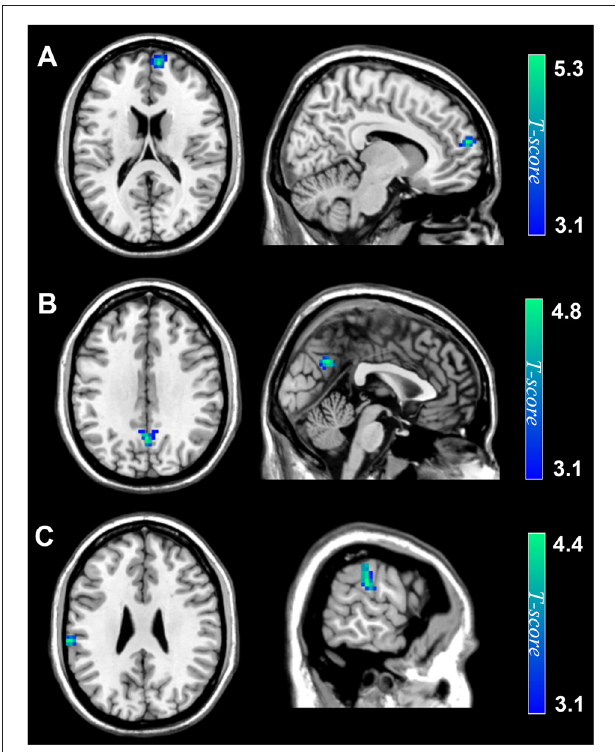
FIGURE 1 | Spontaneous brain activity associations of TTF. Amplitude of low-frequency fluctuations (ALFF) of the dorsomedial prefrontal cortex (dmPFC) (A) , precuneus (B) and inferior parietal lobule (IPL) (C) was negatively correlated with TTF scores. Results are shown at p < 0.05, corrected for multiple comparisons at the cluster-level with topological false discovery rate (FDR) correction. The color density represents the T -score. TTF, tendency to